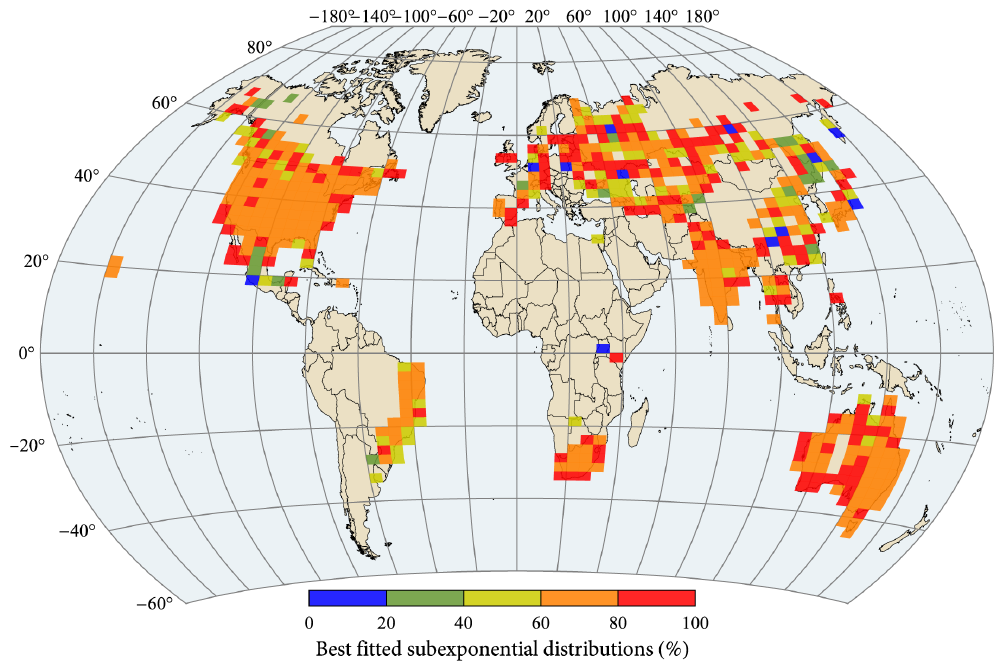
Fig. 8. Geographical variation of the percentage of best fitted subexponential tails in cells defined by latitude difference 1ϕ = 2 . 5 ◦ and longitude difference 1λ = 5 ◦ . In total, in 72.6% of the 15029 records analysed, the subexponential tails were the best fitted.